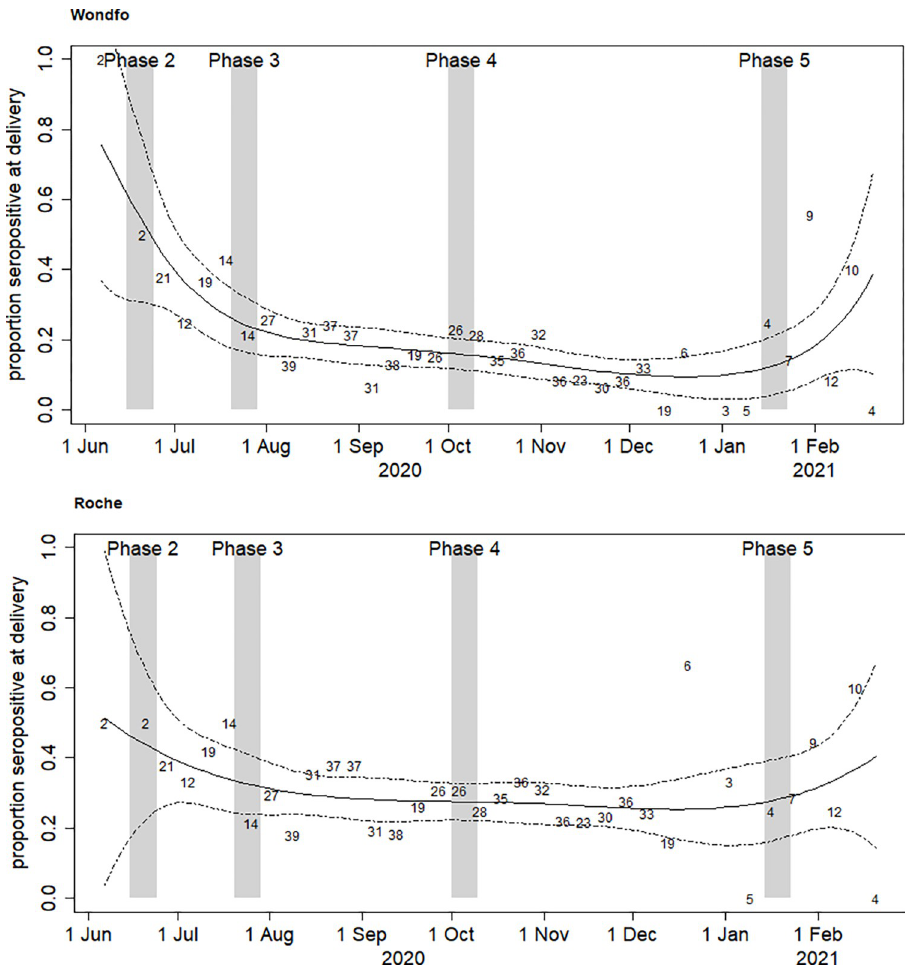
Fig 2. SARS-CoV-2 seroprevalence over time (June 2020-February 2021) among pregnant women at delivery in S ã o Paulo, by Wondfo (Panel A) and Roche Elecsys (Panel B) assays. The grey bars show the dates of the second to fifth household surveys (HHS). The first survey is not shown because it was before the start of the study in pregnant women (see dates in Table 3). The numbers in the body of the figure are the numbers tested in each epidemiological week. The solid line is the estimate of the proportion seropositive from the spline fit, and the two dashed line are the 95% confidence limits.